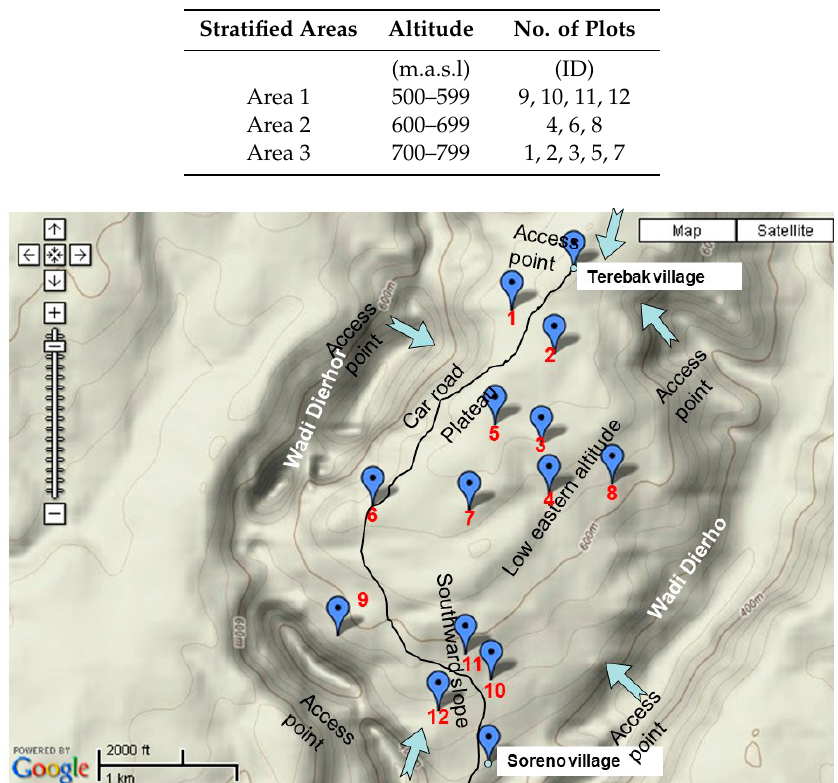
Figure 2. Location of 12 study plots (base map from Google).